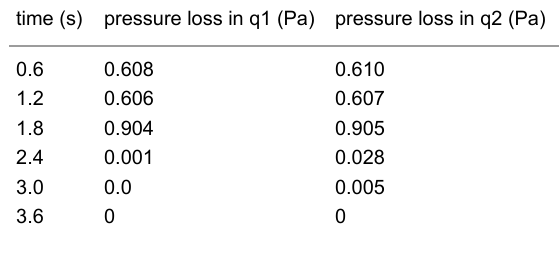
Table 1: Pressure loss of flow during unfolding of the hind wing. time (s) pressure loss in q1 (Pa) pressure loss in q2 (Pa) 0.6 0.608